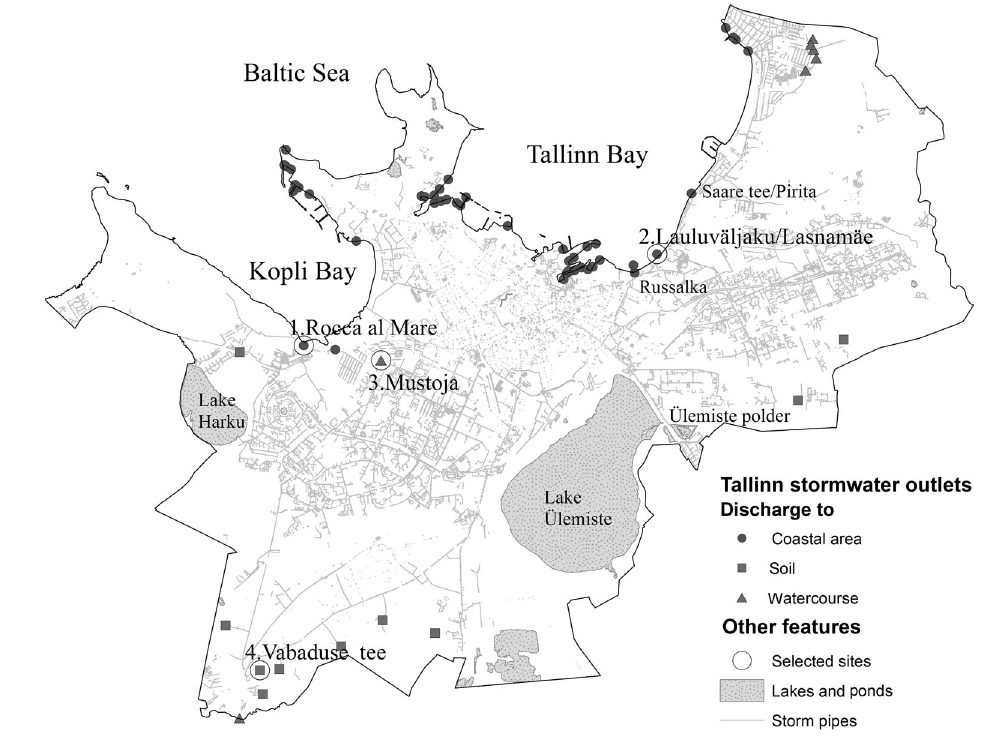
Fig. 2. Stormwater outlets in